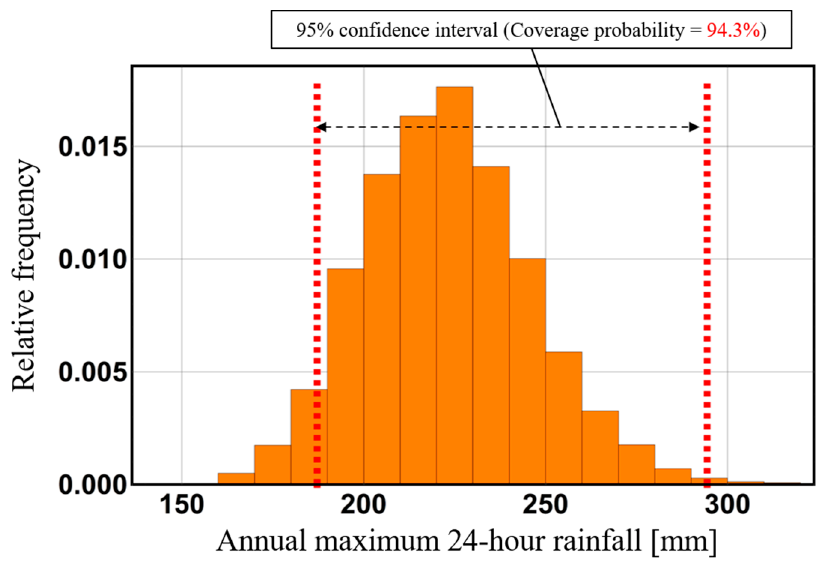
Figure 16. 95% confidence interval of 100-year annual maximum 24-h rainfall based on probability limit method test for future climate vs. histogram of 100-year annual maximum 24-h rainfall generated by resampling projected future experiment data.